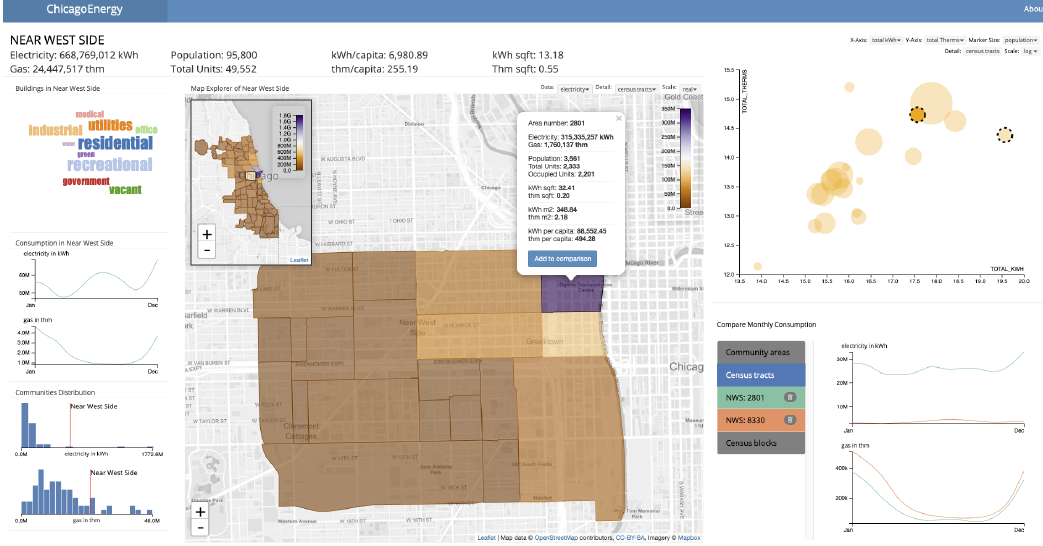
Figure 1. Interactive, web-based, open-source energy consumption explorer for the city of Chicago. The central overview + detail map supports selection and comparison of areas at multiple spatial scales (entire community areas, census tracks, and census blocks) and multiple gas and electricity metrics that can account for population statistics. Details on demand supply additional area statistics. A word cloud, simple charts and histograms (left) enable building-type analysis, global seasonal consumption analysis, and comparison of a selected area against the overall consumption distribution. A scatterplot view and additional seasonal charts support outlier detection and seasonal consumption analysis at smaller spatial scales, selected by the